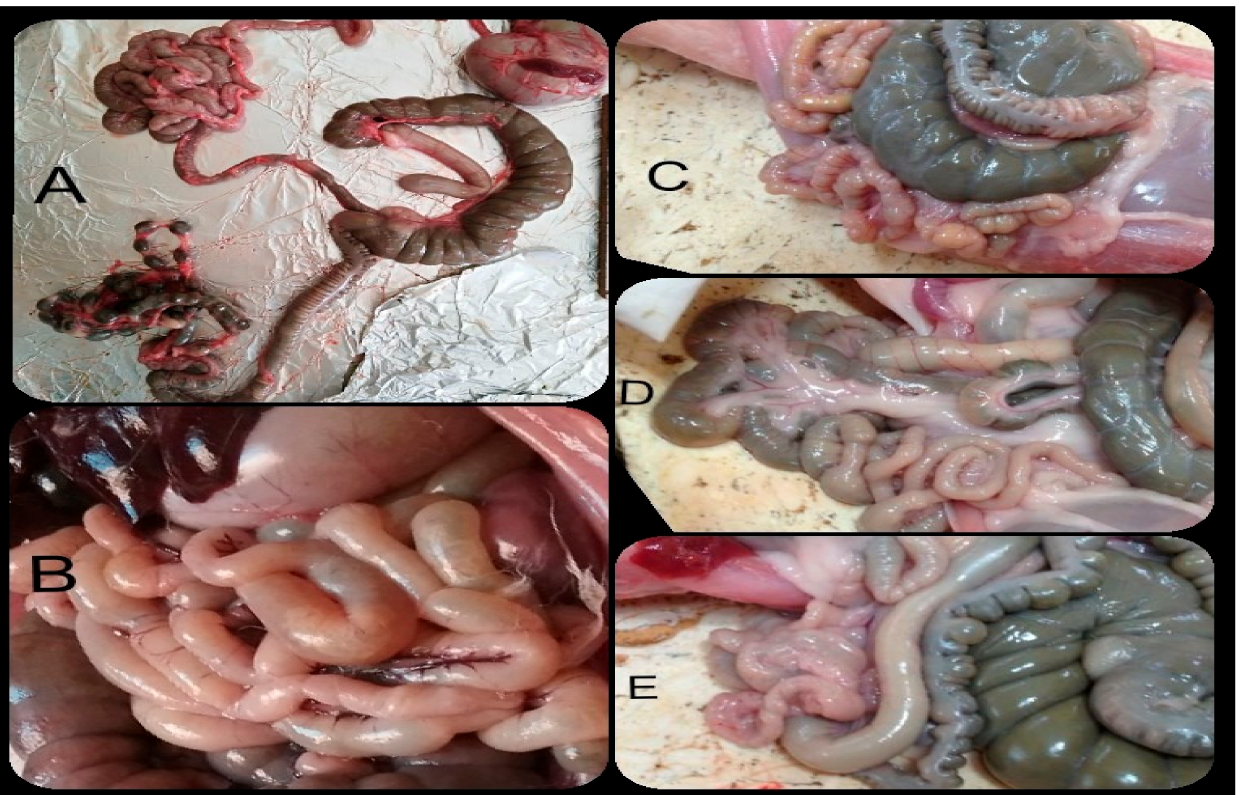
Figure 1. The macroscopic findings in the intestines in the experimental groups showing hyperemic wall, fluid contents, and multiple white patches on the mucosal surface with the highest score of 3 in the positive control group ( B ), a score of 2 in the pomegranate peel extract-treated group showing scattered white patches ( D ), a score of 1 in the neem leaf extract-treated group showing mild distention with grey green semisolid content ( C ), a score of 0 in the combined treated group ( E ), and in the negative control ( A ) apparently normal architecture. Data obtained from 3